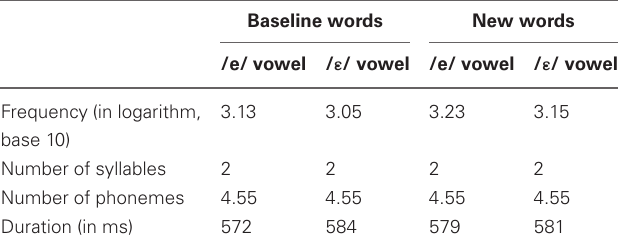
Table 1 | Characteristics of the words used in the experiment (mean values).